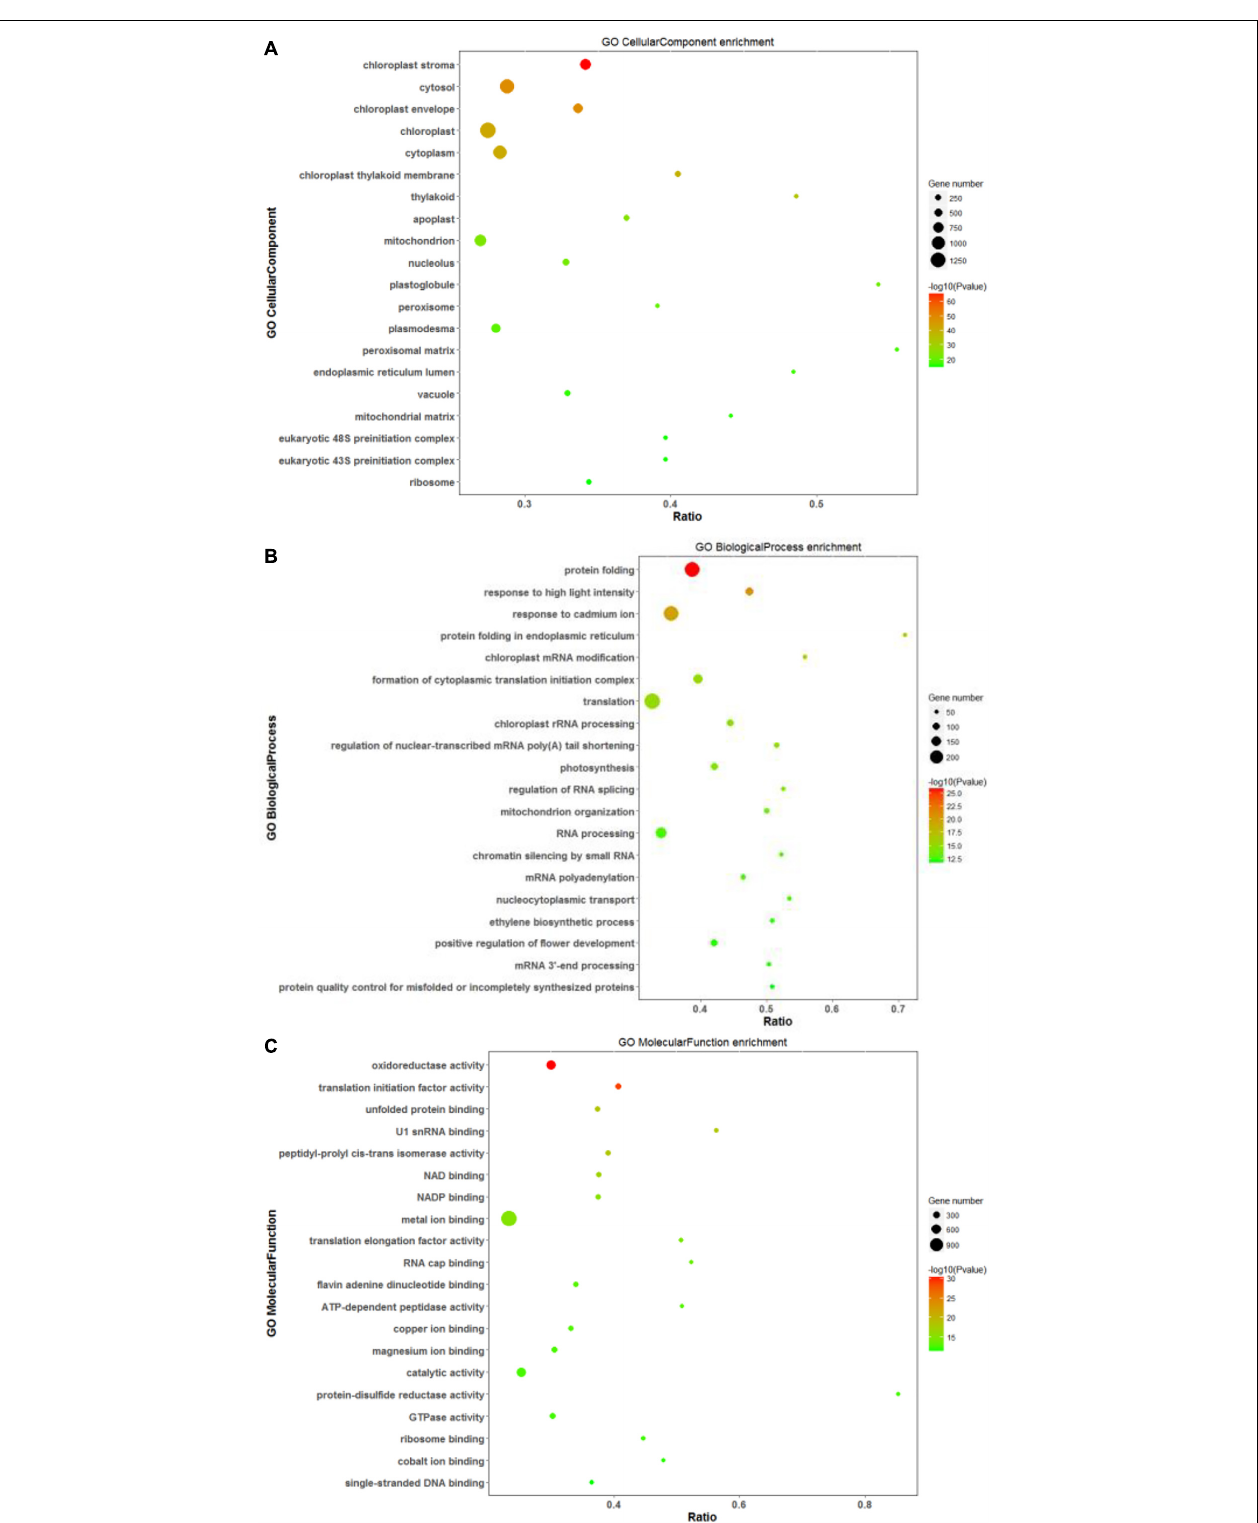
Frontiers in Plant Science |